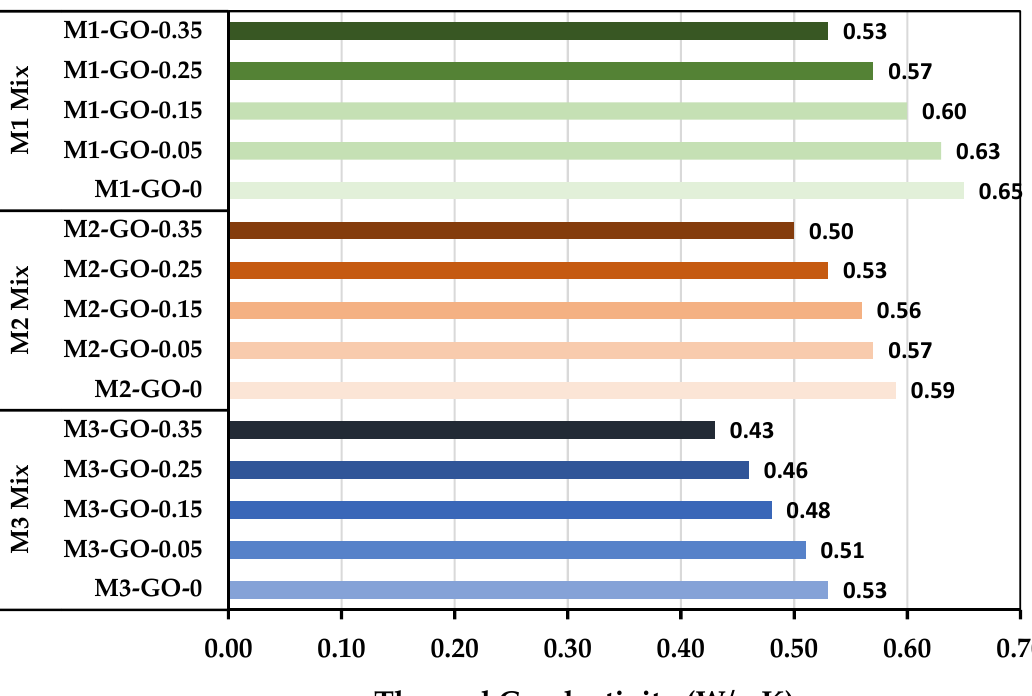
Figure 9. Thermal conductivity of samples.